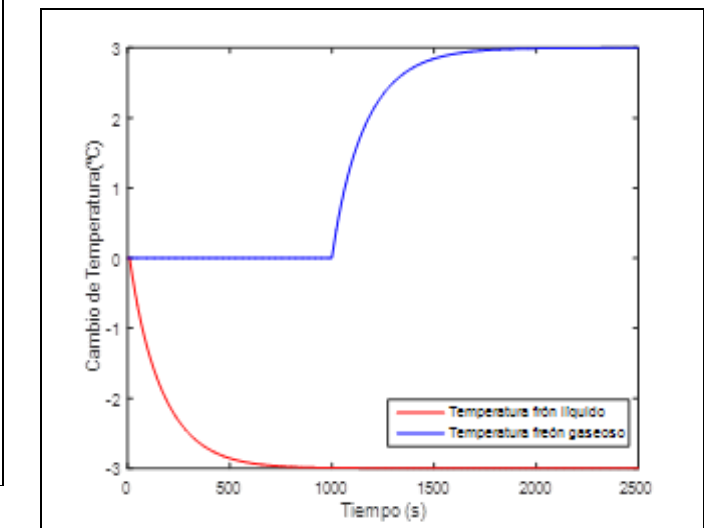
Figura 8: Respuesta del sistema multivariable con controladores de Síntesis Directa y